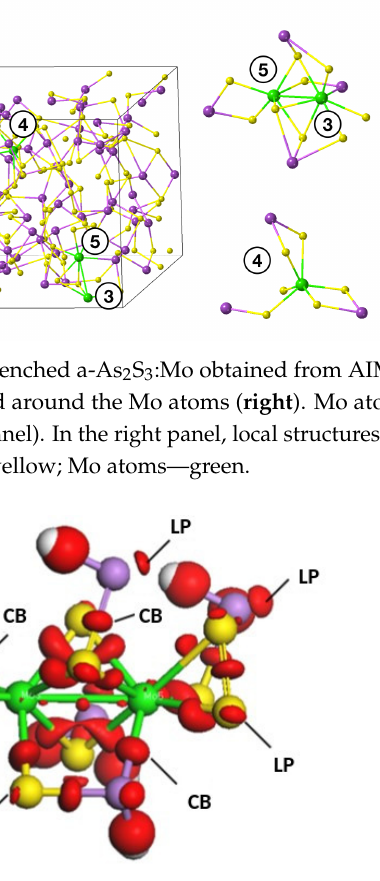
Figure 3. A fragment of Mo-doped a-As 2 S 3 . Dangling bonds are saturated with hydrogen atoms (grey). As atoms—violet; S atoms—yellow; Mo atoms—green. Charge Density Difference is shown in red for covalent bonds (CBs) and lone-pairs